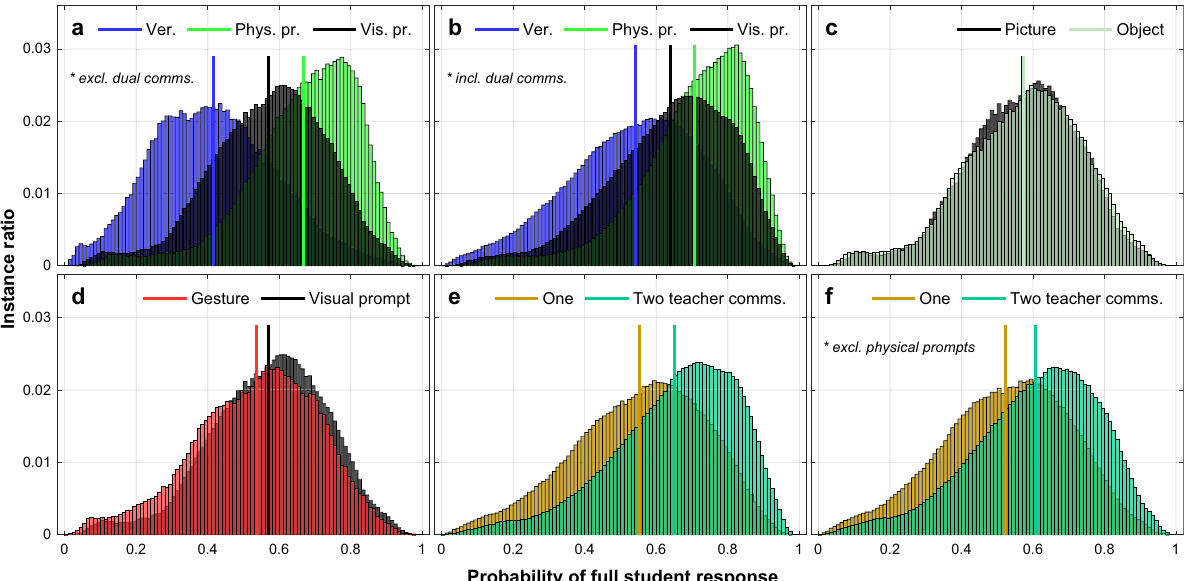
Fig. 3 Probability distribution of full student response under various scenarios, using the machine learning classi fi er. The following scenarios are explored: a comparison between verbal teacher communications, physical, and visual prompts when only a single communication is applied; b comparison between verbal teacher communications, physical, and visual prompts, including instances where two (dual) communications are applied; c comparison between picture and object teacher communications (i.e. between the two visual prompts); d comparison between gestures and visual prompts; e comparison between one and two teacher communications; f comparison between one and two teacher communications when communications with a physical prompt are excluded. Straight vertical lines denote the mean of the corresponding